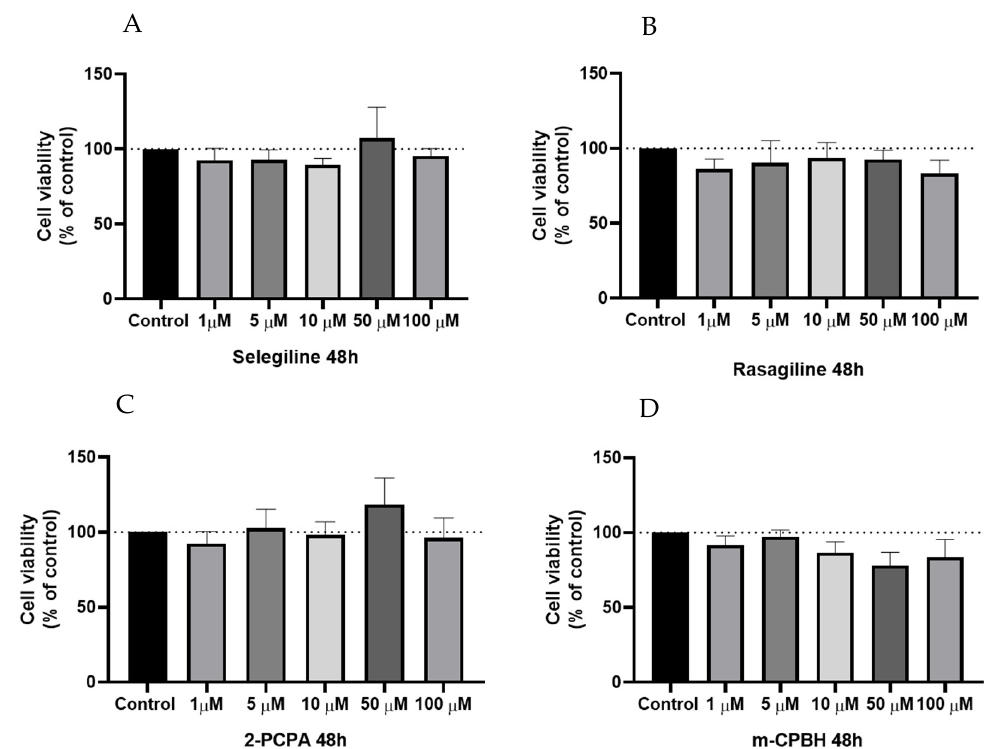
Figure 10. There was no significant effect on cell viability (% of control) in MCF-7 cells treated with selegiline ( A ), rasagiline ( B ), 2-PCPA ( C ) and m-CPBH ( D ) at the chosen concentrations over 48 h. Three or more independent experiments were performed for each drug ( n ≥ 3). Results are expressed as mean ± standard error of the mean (SEM).